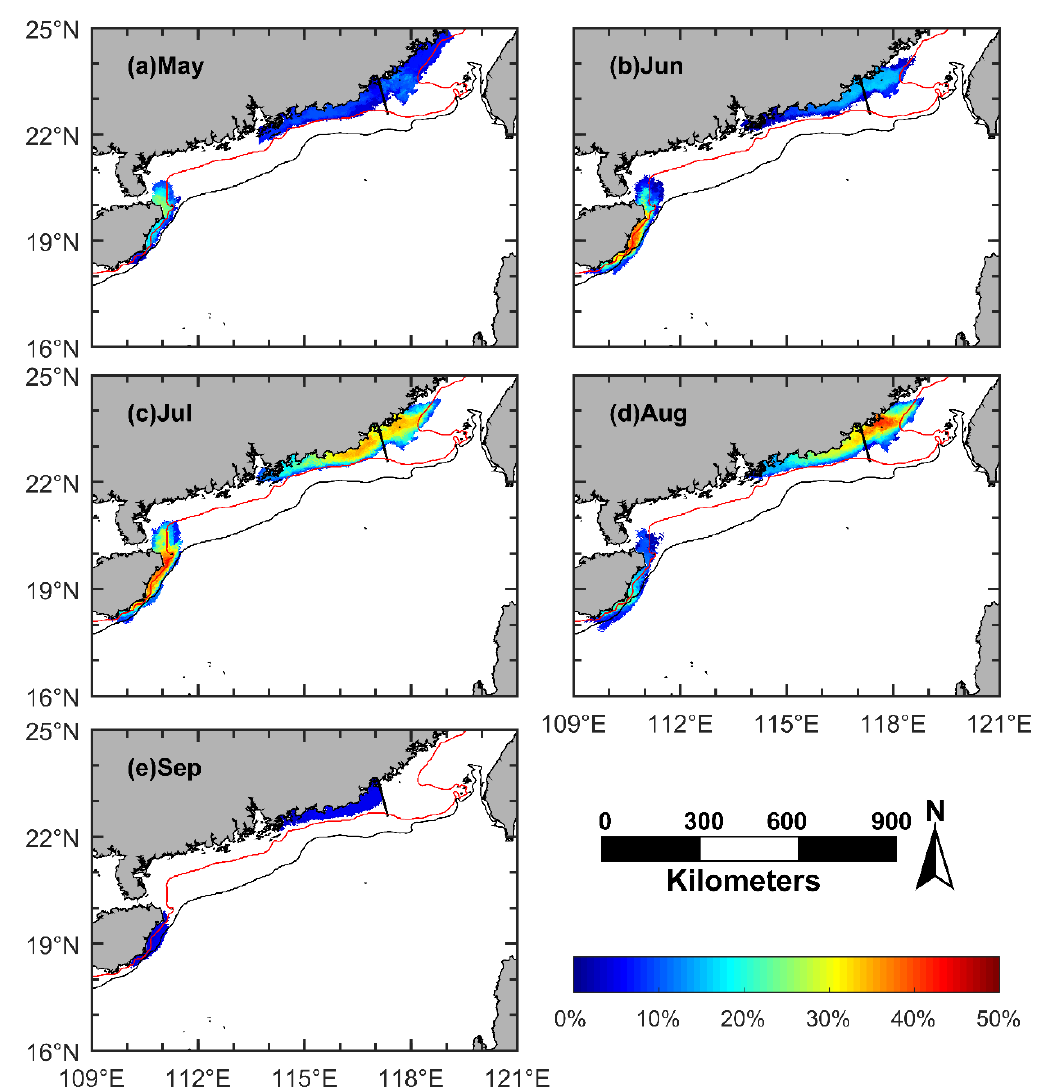
Figure 7. The monthly frequency of occurrence and the influence area of the coastal upwelling in the northern South China Sea (NSCS), generated by combining the daily upwelling maps in the corresponding month regardless of the year. ( a ) May; ( b ) June; ( c ) July; ( d ) August; ( e ) September. Red line: 40 m isobath; black line: 75 m isobath; black solid line: boundary between the Minnan coastal upwelling and the Yuedong coastal upwelling.